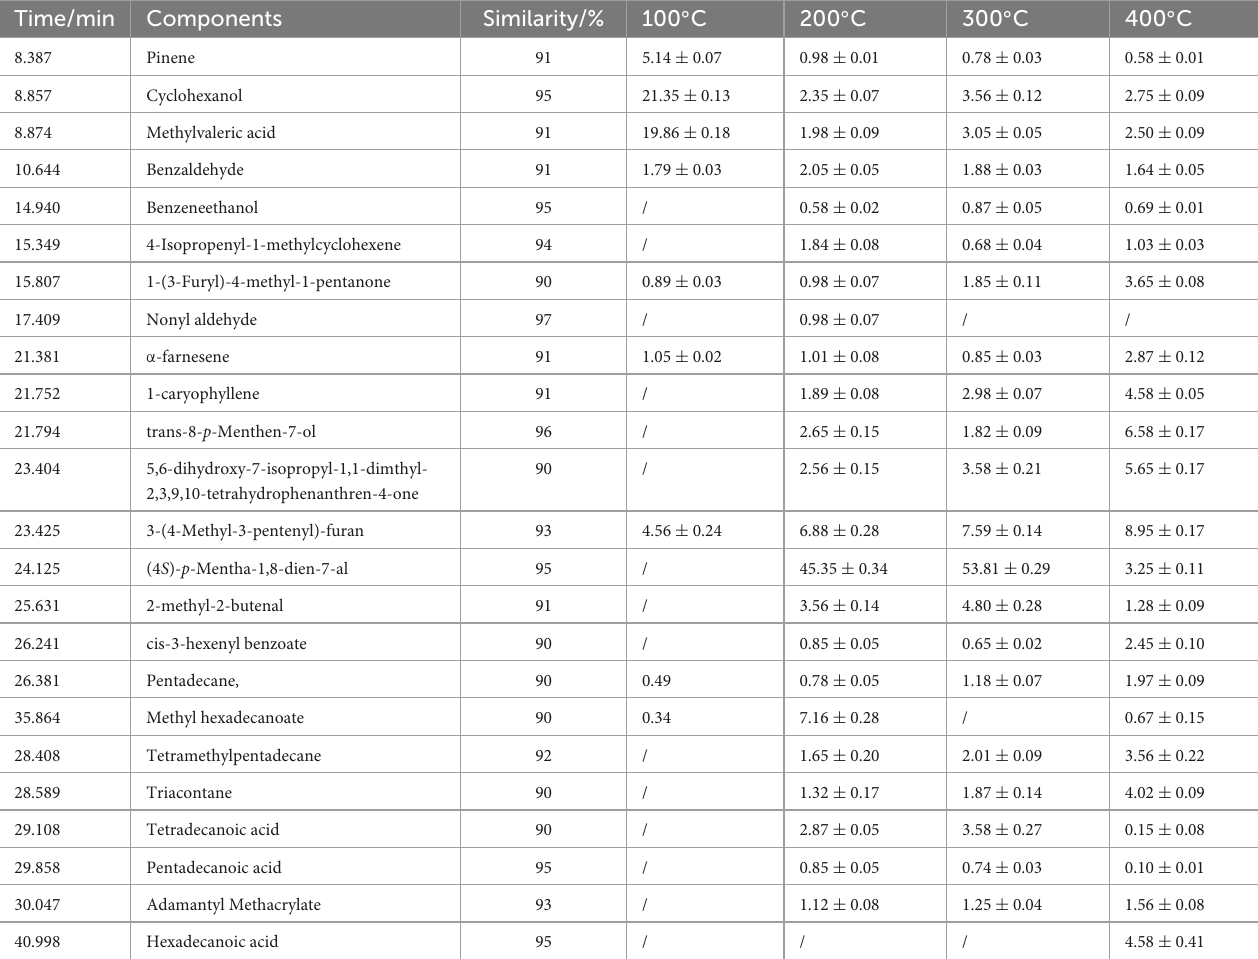
TABLE 1 Thermal decomposition product of Perilla essential oil microcapsules (PEOM) at different temperature. Time/min